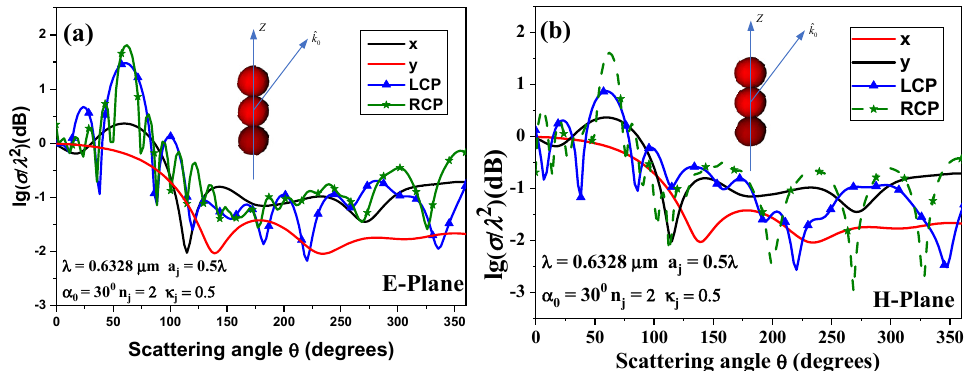
Figure 4. Angular distributions of normalized RCS induced by HOBB depending on the polarization states. ( a ) E-plane; ( b ) H-plane.